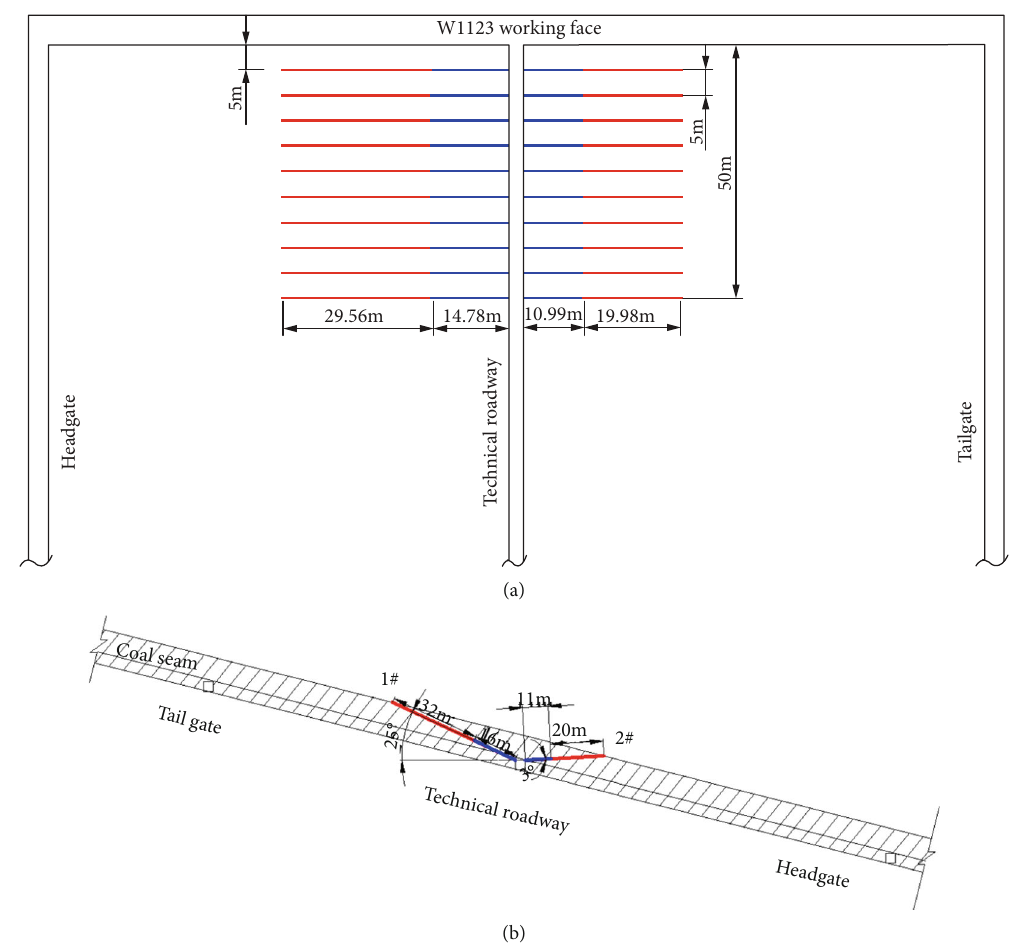
Figure 18: Blasthole layout scheme. (a) Plane diagram. ( b ) Section diagram. Table 6: parameters of deep-hole blasting, hole drilling, and fi lling